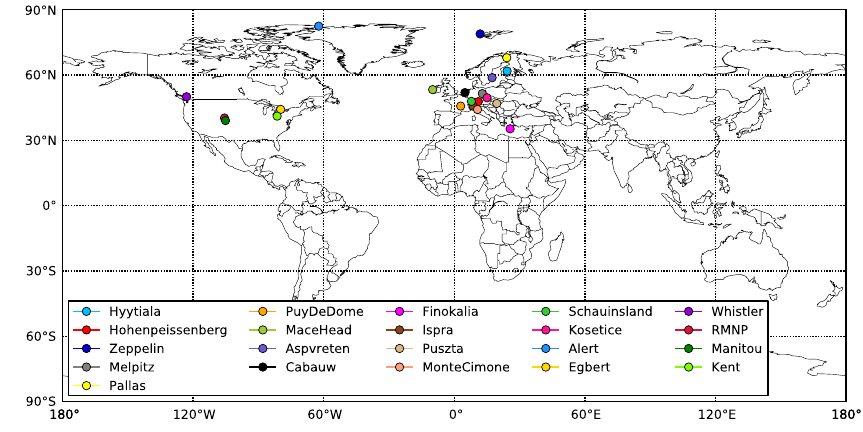
Fig. 1. Locations of the surface-based measurement sites used in this study. Figure 1. Locations of the surface-based measurement sites used in this study. Table 1. Summary of the GEOS-Chem-TOMAS simulations performed in this study. Simulation